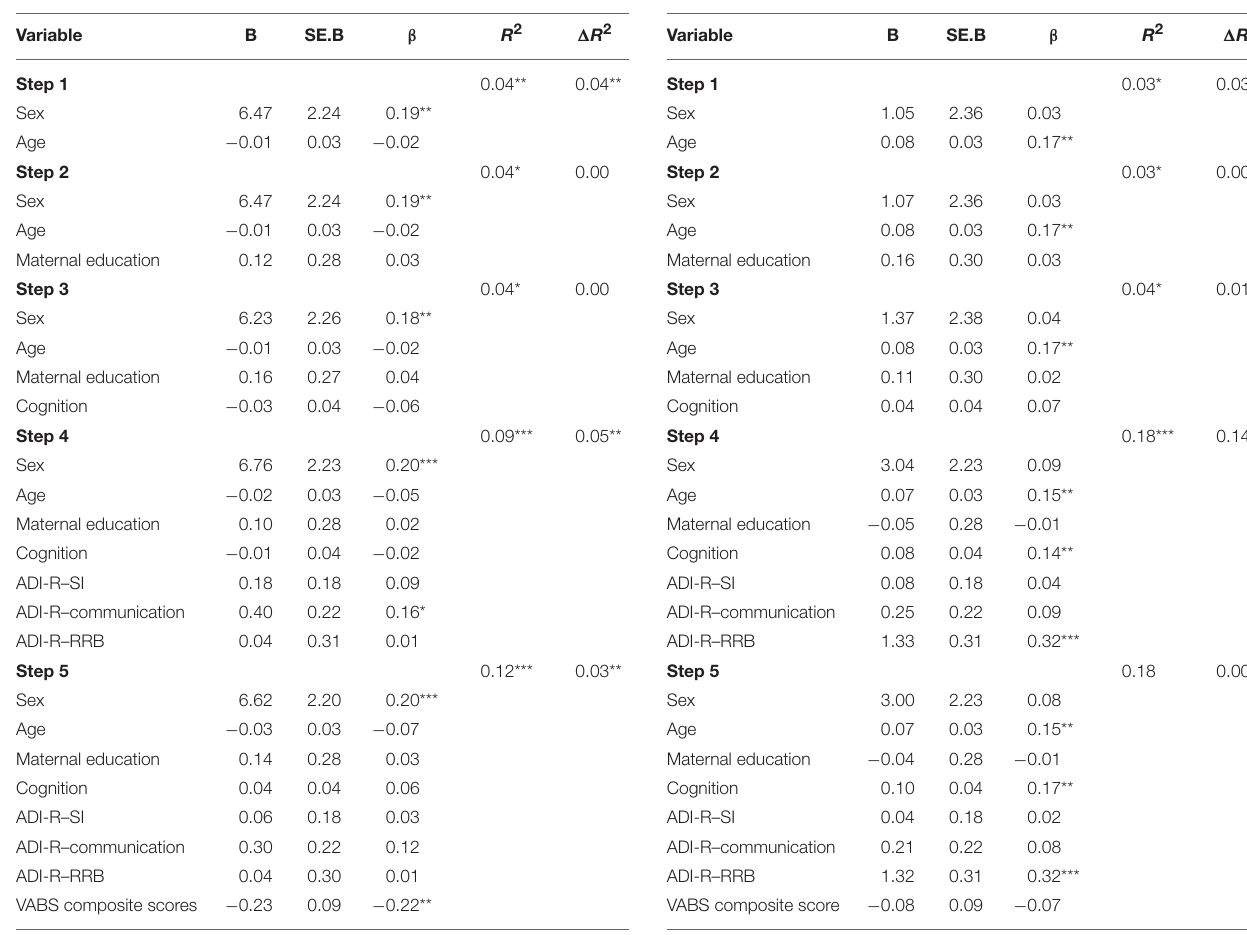
TABLE 7 | Linear regression model for the CPRS HI